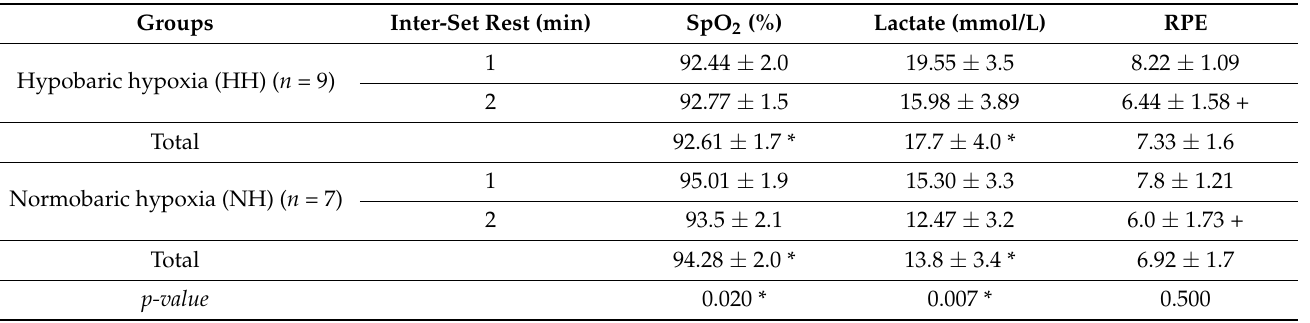
Table 1. Control variables after training